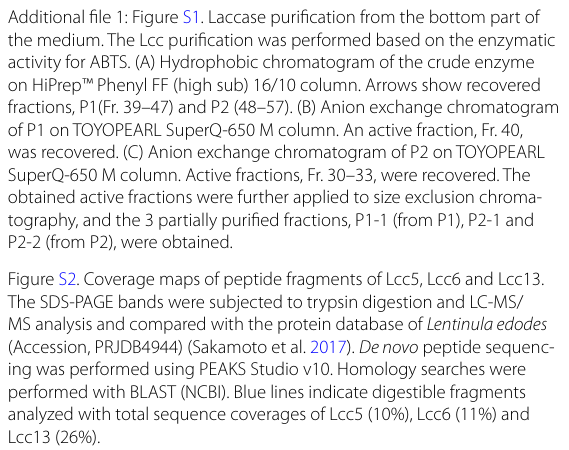
Figure S2. Coverage maps of peptide fragments of Lcc5, Lcc6 and Lcc13. The SDS-PAGE bands were subjected to trypsin digestion and LC-MS/ MS analysis and compared with the protein database of Lentinula edodes (Accession, PRJDB4944) (Sakamoto et al. 2017). De novo peptide sequenc- ing was performed using PEAKS Studio v10. Homology searches were performed with BLAST (NCBI). Blue lines indicate digestible fragments analyzed with total sequence coverages of Lcc5 (10%), Lcc6 (11%) and Lcc13